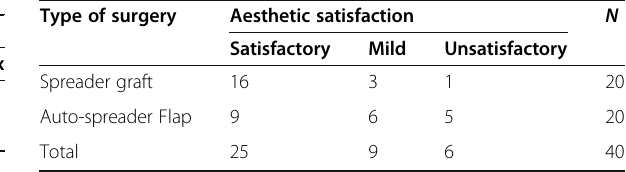
Table 2 Patients satisfaction among spreader graft and auto- spreader flap